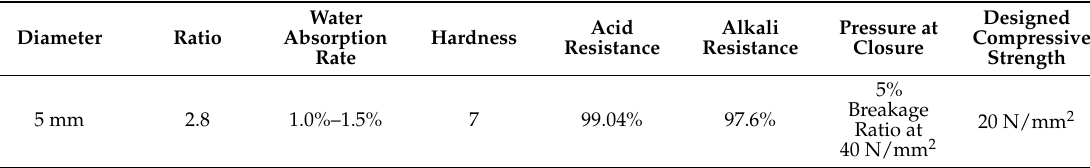
Table 1. Characteristics of the marbles.